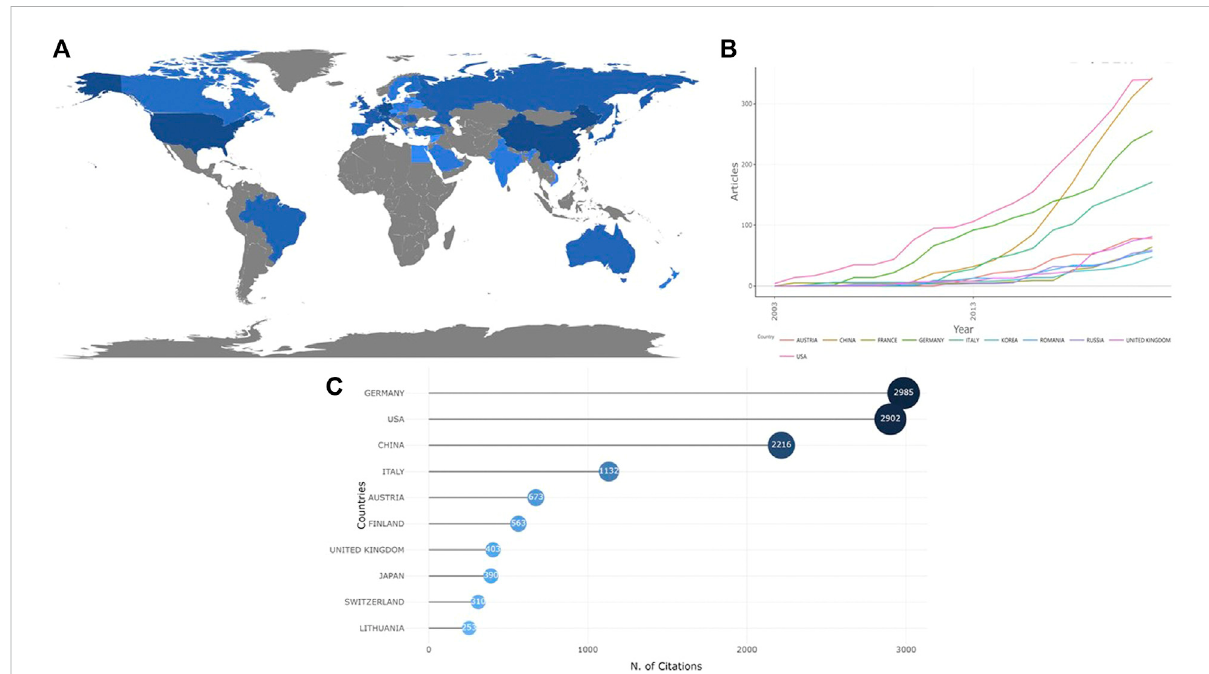
FIGURE 2 Contributions of different countries regarding the research of TPP applications in biomedical fi eld. (A) Global country scienti fi c production contributions; (B) Production ofthetop 10 countries with thehighestproductivity over time; (C) Numberof publications inthetop 10countrieswith the highest